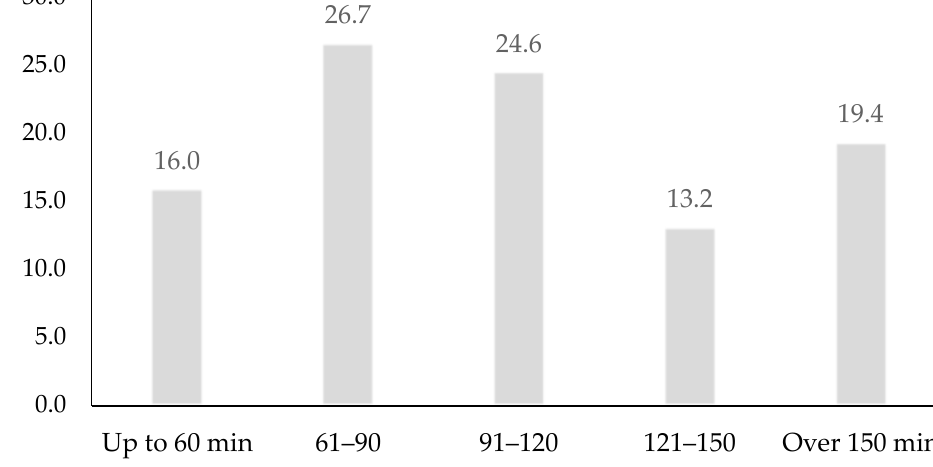
Figure 1. Prevalence (%) of time (minutes) spent on leisure activities.